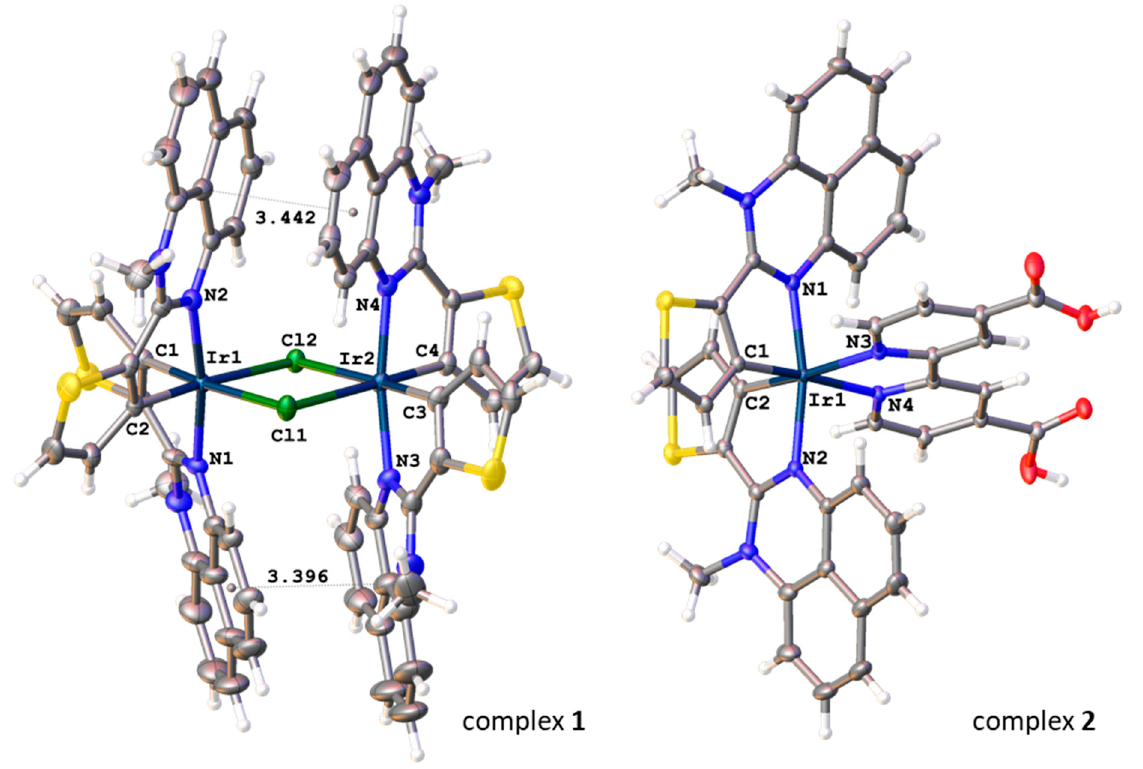
Figure 6. Molecular structures of 1 and 2 . Displacement ellipsoids are drawn at the 50% probability level.